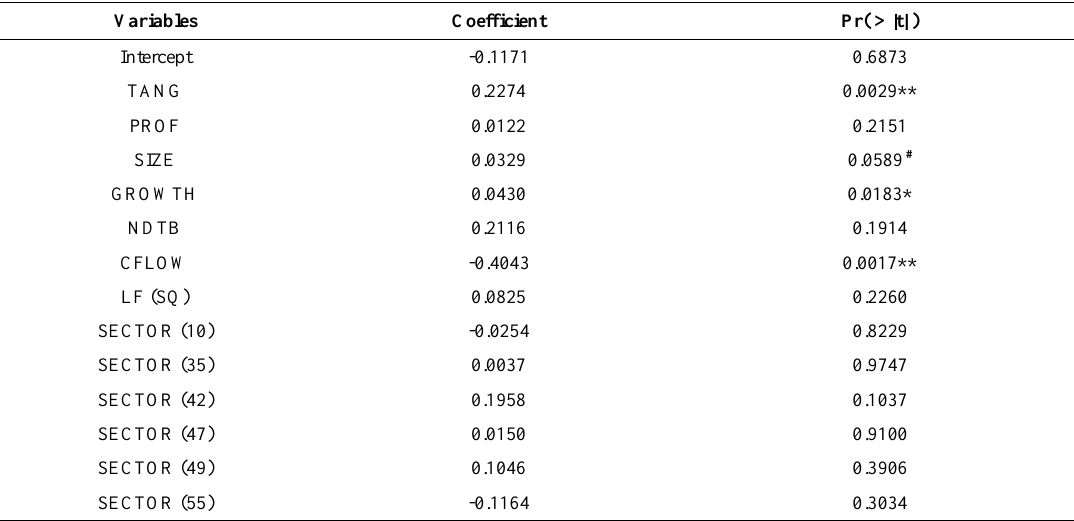
Table 6. Estimates of panel data model with random effects for individuals, considering all explanatory